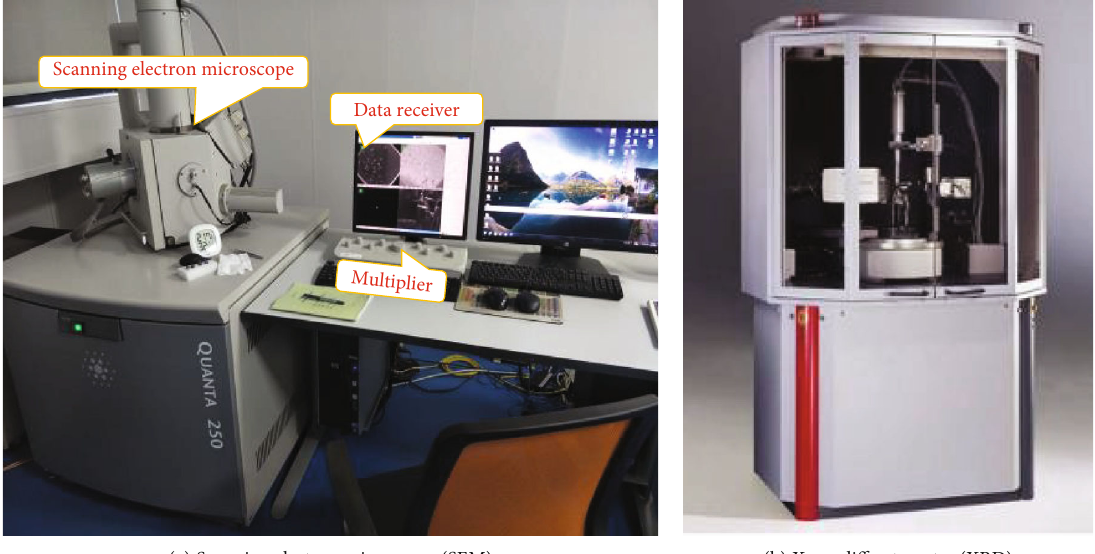
Figure 7: Equipment used for microstructural analysis.